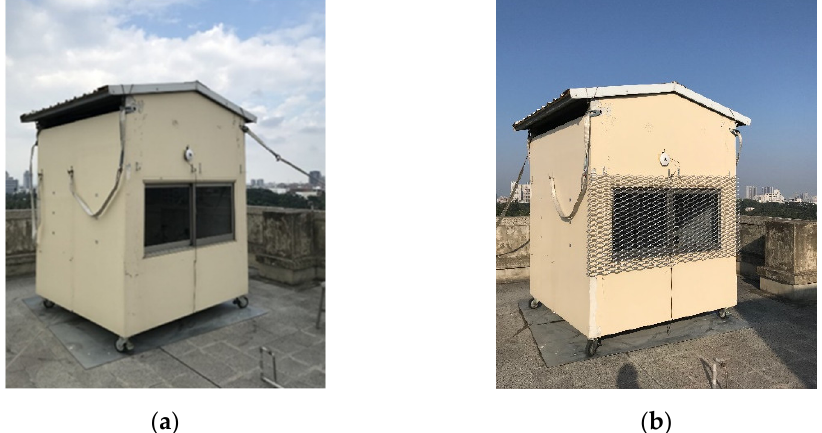
Figure 2. Photo of experimental house. ( a ) Without Expanded Metal Mesh; ( b ) With Expanded Metal Mesh.